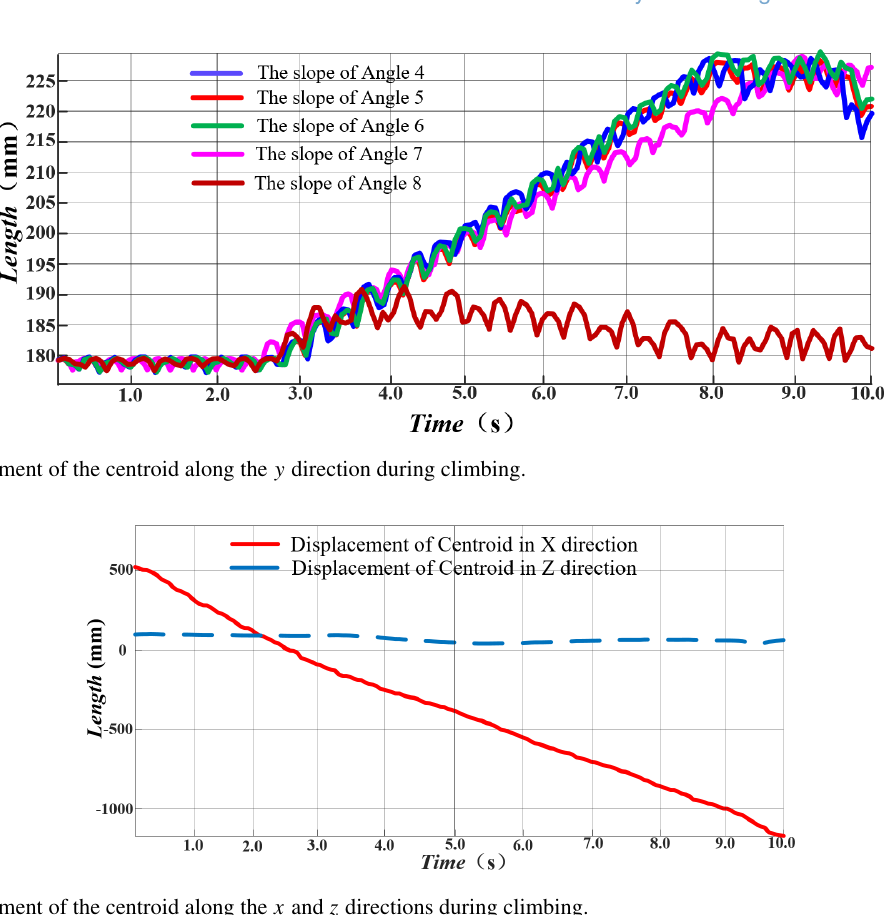
Figure 15. Displacement of the centroid along the x and z directions during climbing.